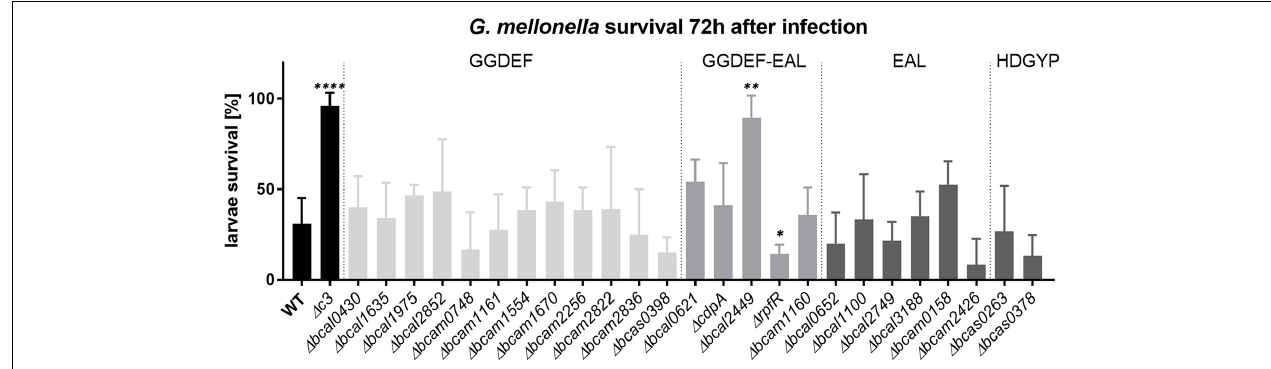
FIGURE 7 | Virulence of B. cenocepacia H111 and PDE/DGC mutants in G. mellonella . Ten larvae were infected with 10.000–20.000 B. cenocepacia wild type or mutants, and killing was observed over 3 days. Data presented here show mean and standard deviations of larvae survival of at least 3 independent experiments per strain 72 h after infection. Knockout mutants of genes coding for GGDEF-only proteins are highlighted in light gray, those encoding composite GGDEF-EAL proteins in gray, EAL-only proteins and HD-GYP-domain proteins in dark gray, wild type and (cid:49) c3 control in black, respectively. Asterisks indicate P < 0.05 with unpaired t -test with wild type control.